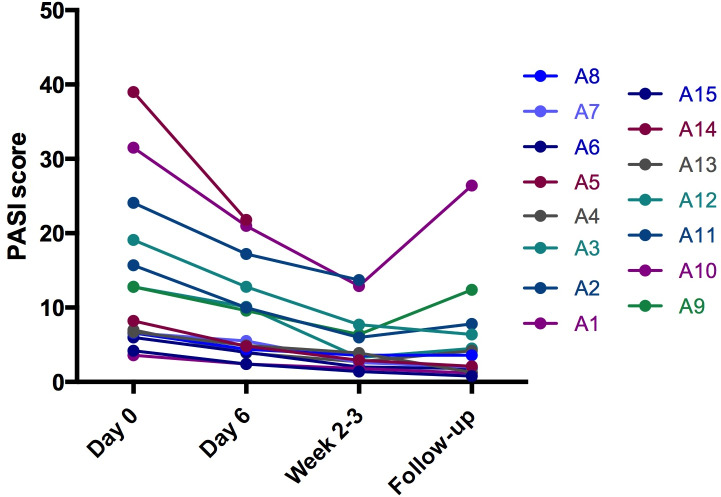
Psoriasis area and severity (PASI) score at baseline (day 0), early during treatment (day 6), at end of treatment (week 2–3) and at follow-up (4–6 weeks after end of treatment) for all 15 patients (A1–A15) treated with dithranol.Figure 1—figure supplement 1—source data 1.Values displayed in graph shown in Figure 1—figure supplement 1.